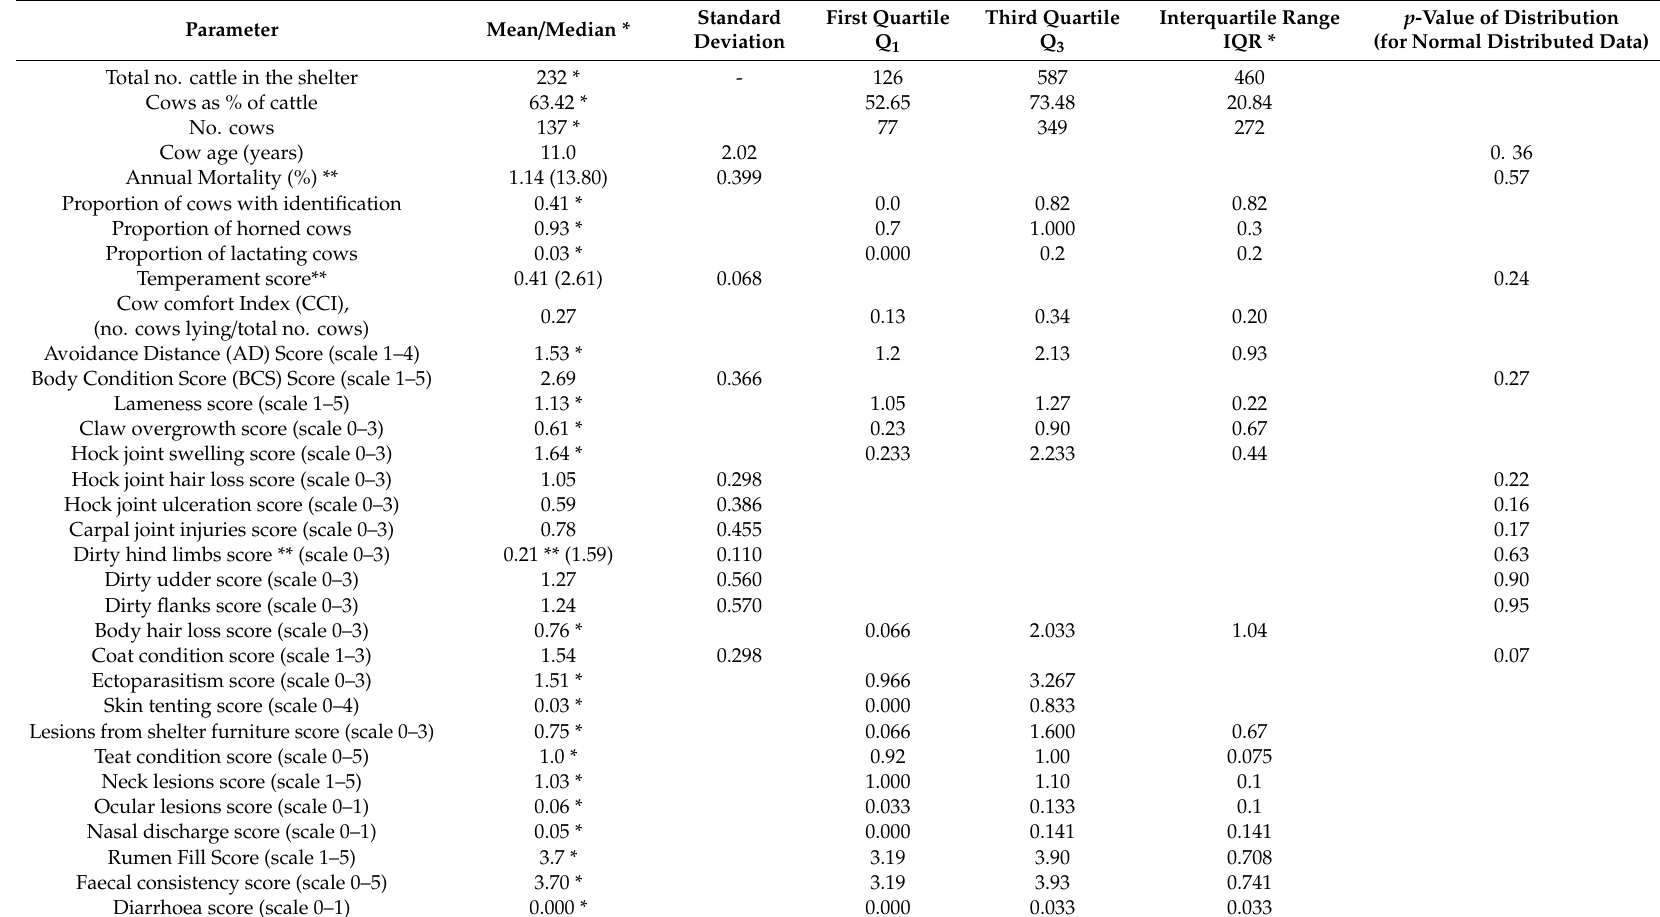
Table 1. Descriptive statistics for animal-based measures in the cow shelters, measured on ordinal and continuous scales. Parameter Mean / Median *